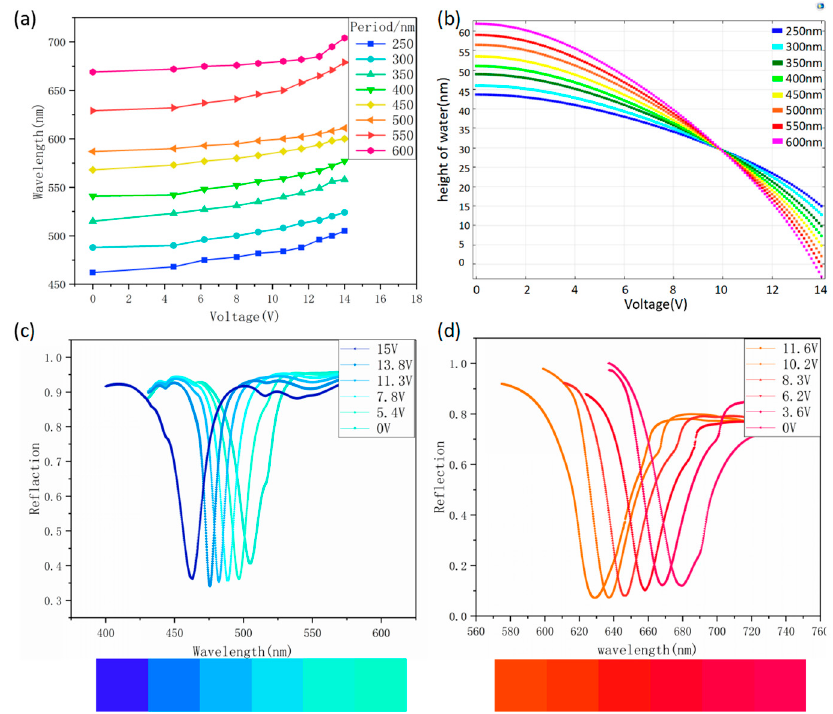
Figure 3. ( a ) The relationship of extinction wavelengths with the electrowetting voltages. ( b ) A schematic representation of the centre point height of the oil–water interface as a function of voltage. ( c , d ) Reflection peaks at different voltages for periods of 250 nm and 550 nm, respectively.